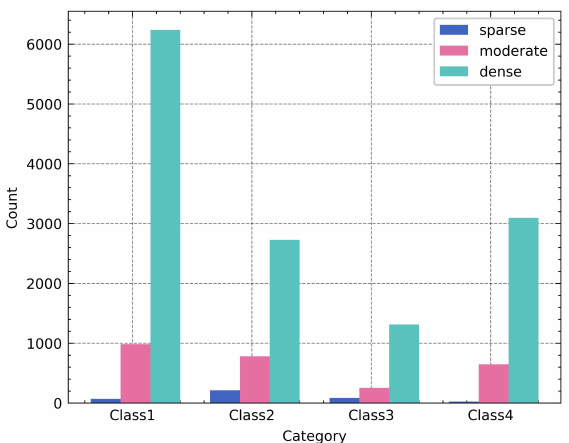
Figure 5. Traffic density feature for each category of the Brest, France validation